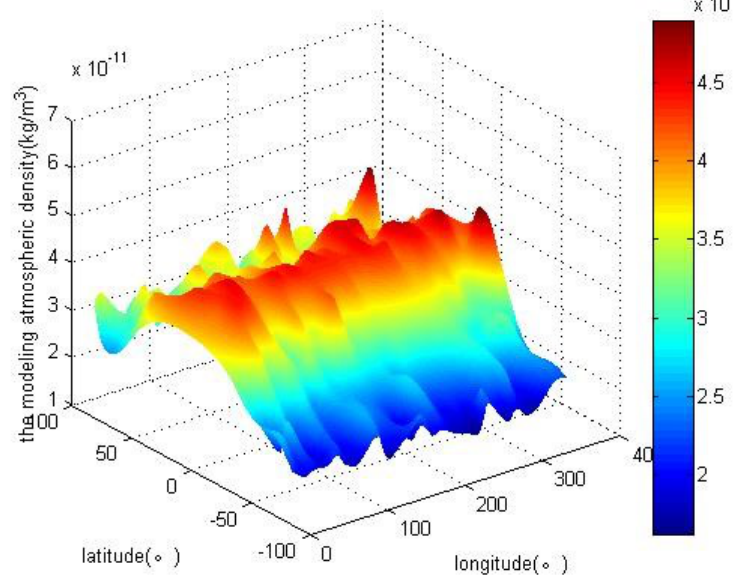
Fig. 6. Global atmospheric density F 30 neural networks model simulation results in March 2012